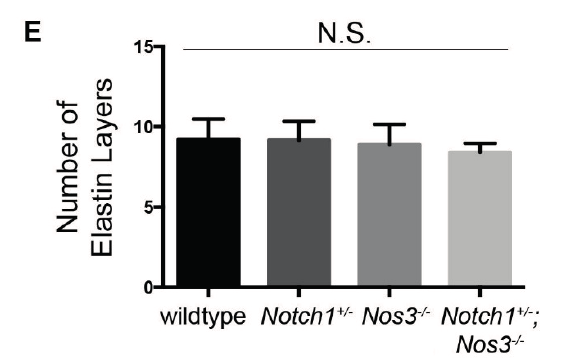
Figure 4. No difference in basic morphometrics of the aortic wall in Notch1 +/ − ; Nos3 − / − mice as compared to littermate controls. Quantification of total aortic wall thickness ( A ); medial thickness ( B ); elastic layer thickness ( C ); distance between elastic layers ( D ); and number of elastin layers ( E ). N.S., not statistically significant. N = 3 per for each